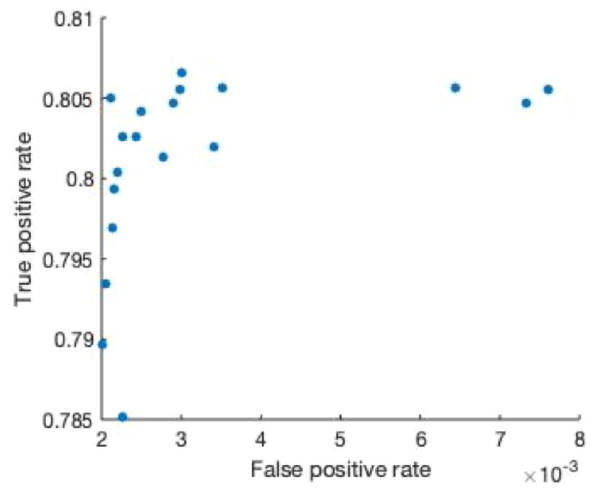
Figure 2. ROC curve for the ascites correction threshold. The threshold value was varied from 0 to 50 HU in increments of 5 HU to construct this curve. From 10 to 20 HU, the threshold was varied in increments of 1